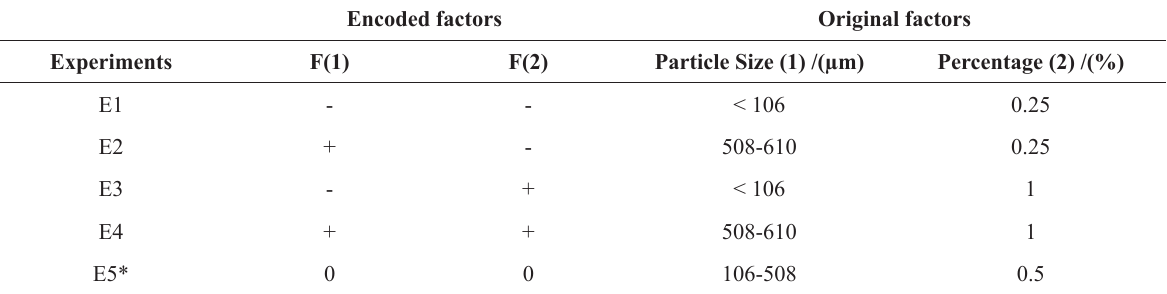
Experiments of factorial design 2 2 with center points employed to evaluate the factors particle size and biochar percentage on sorption and behavior of CMZ into soil amended with